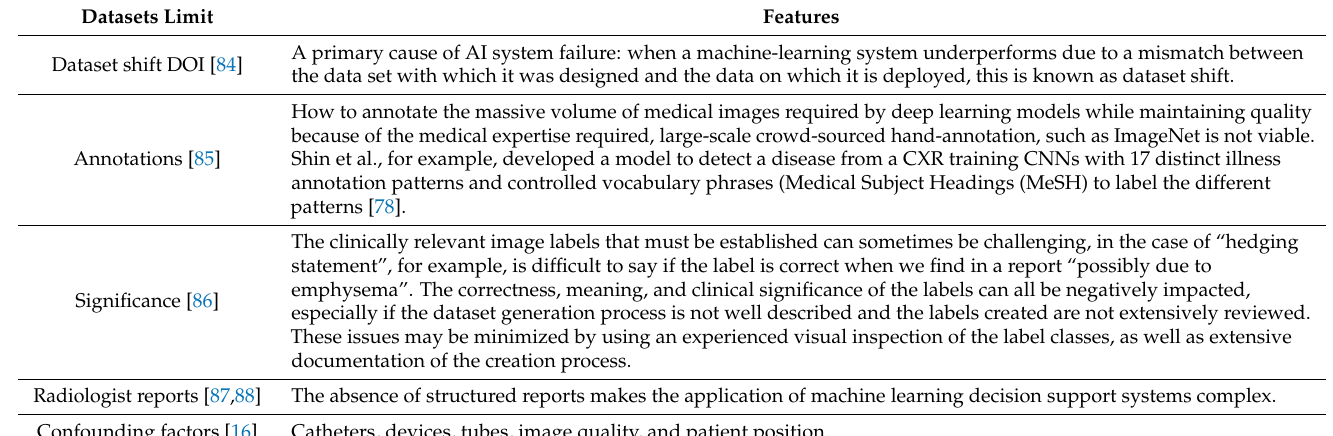
Table 3. This Table lists the main limitations related to the datasets used to develop AI